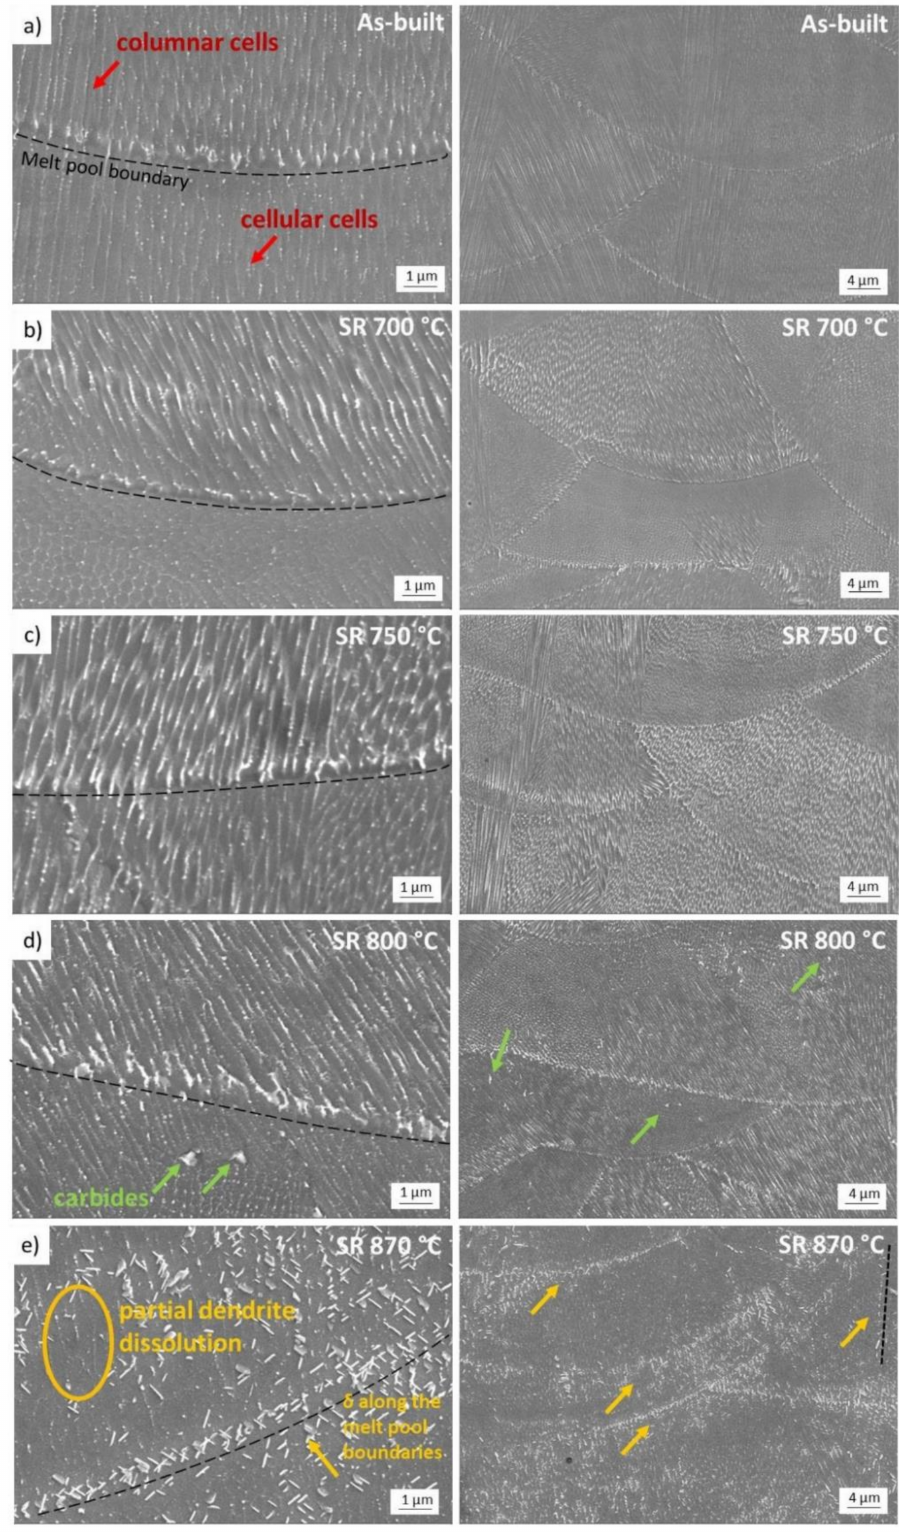
Figure 5. High (left images) and low magnification (right images) SEM micrographs for as-built condition ( a ) and for each stress-relieved state analysed ( b – e